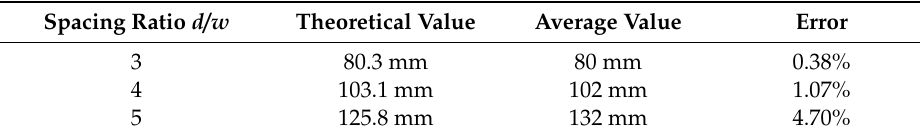
Table 4. Error statistics of peak point X pp